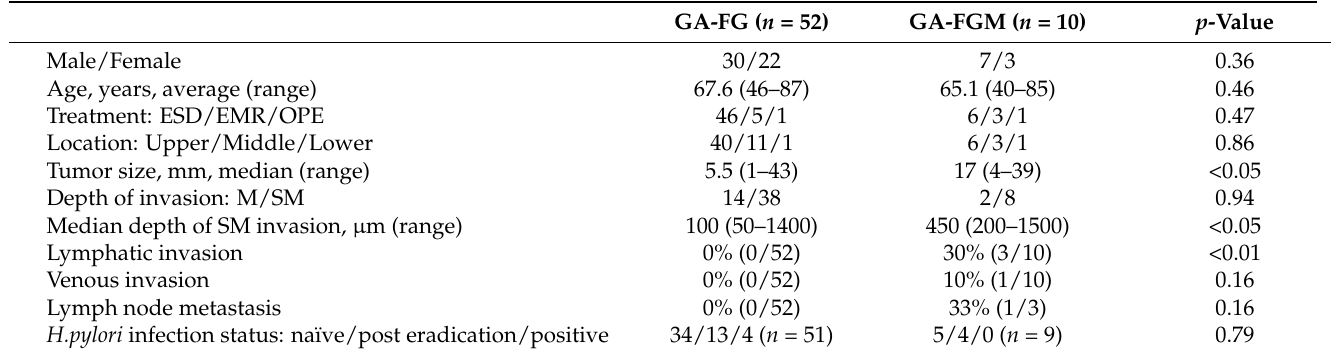
Table 3. Clinicopathological features of GEN-FGML.